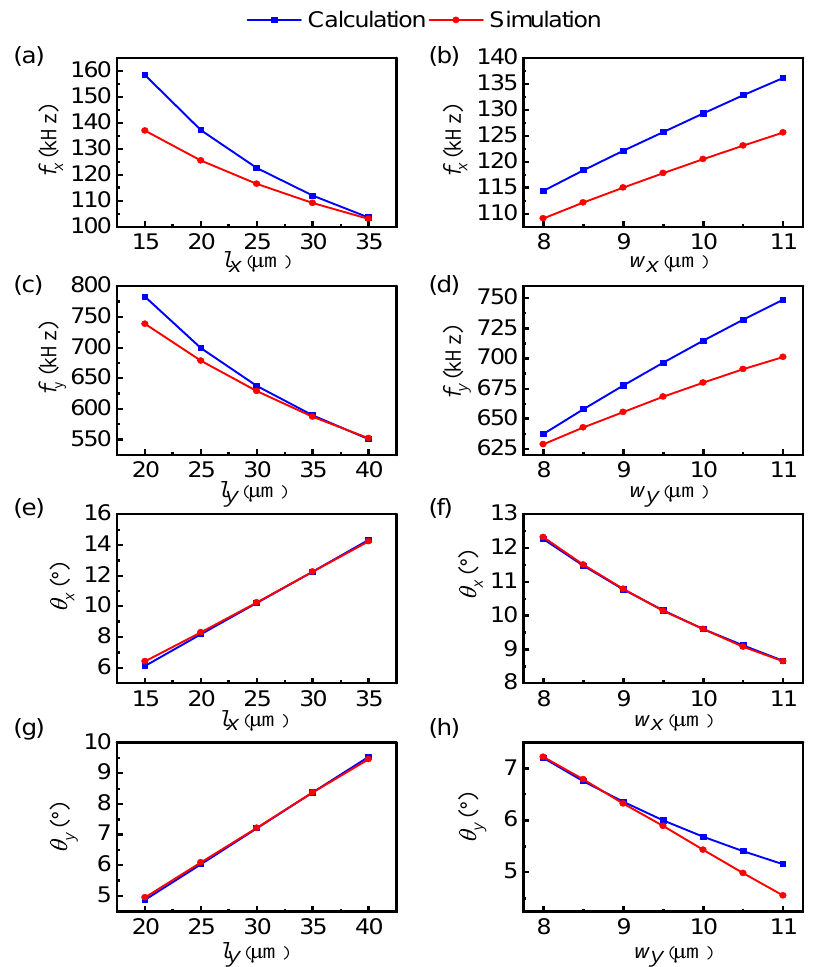
Figure 7. The dependence of the resonant frequency on the structural parameters: ( a ) l x , ( b ) w x , ( c ) l y and ( d ) w y ; The dependence of the mechanical deflection angle on the structural parameters: ( e ) l x , ( f ) w x , ( g ) l y and ( h ) w y